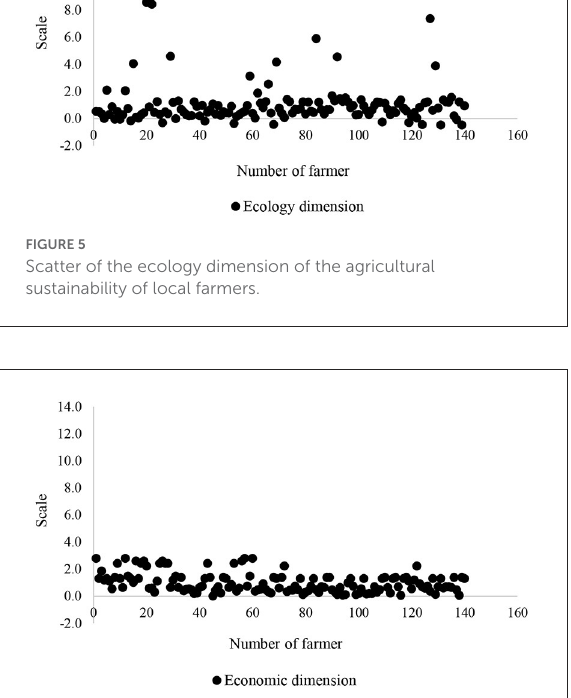
FIGURE6 Scatter of the economic dimension of the agricultural sustainability of local farmers.